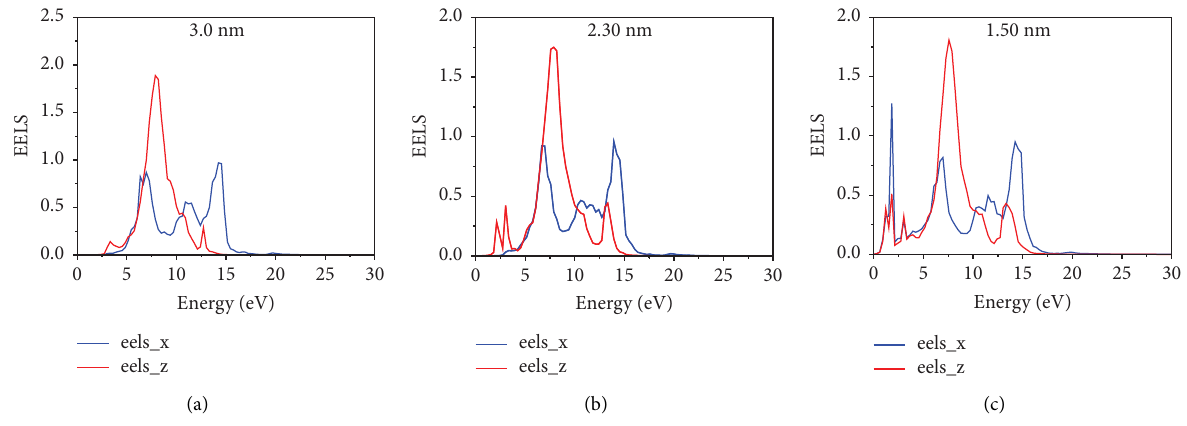
Figure 10: Electron energy loss spectrum for armchair CBNNT under diferent